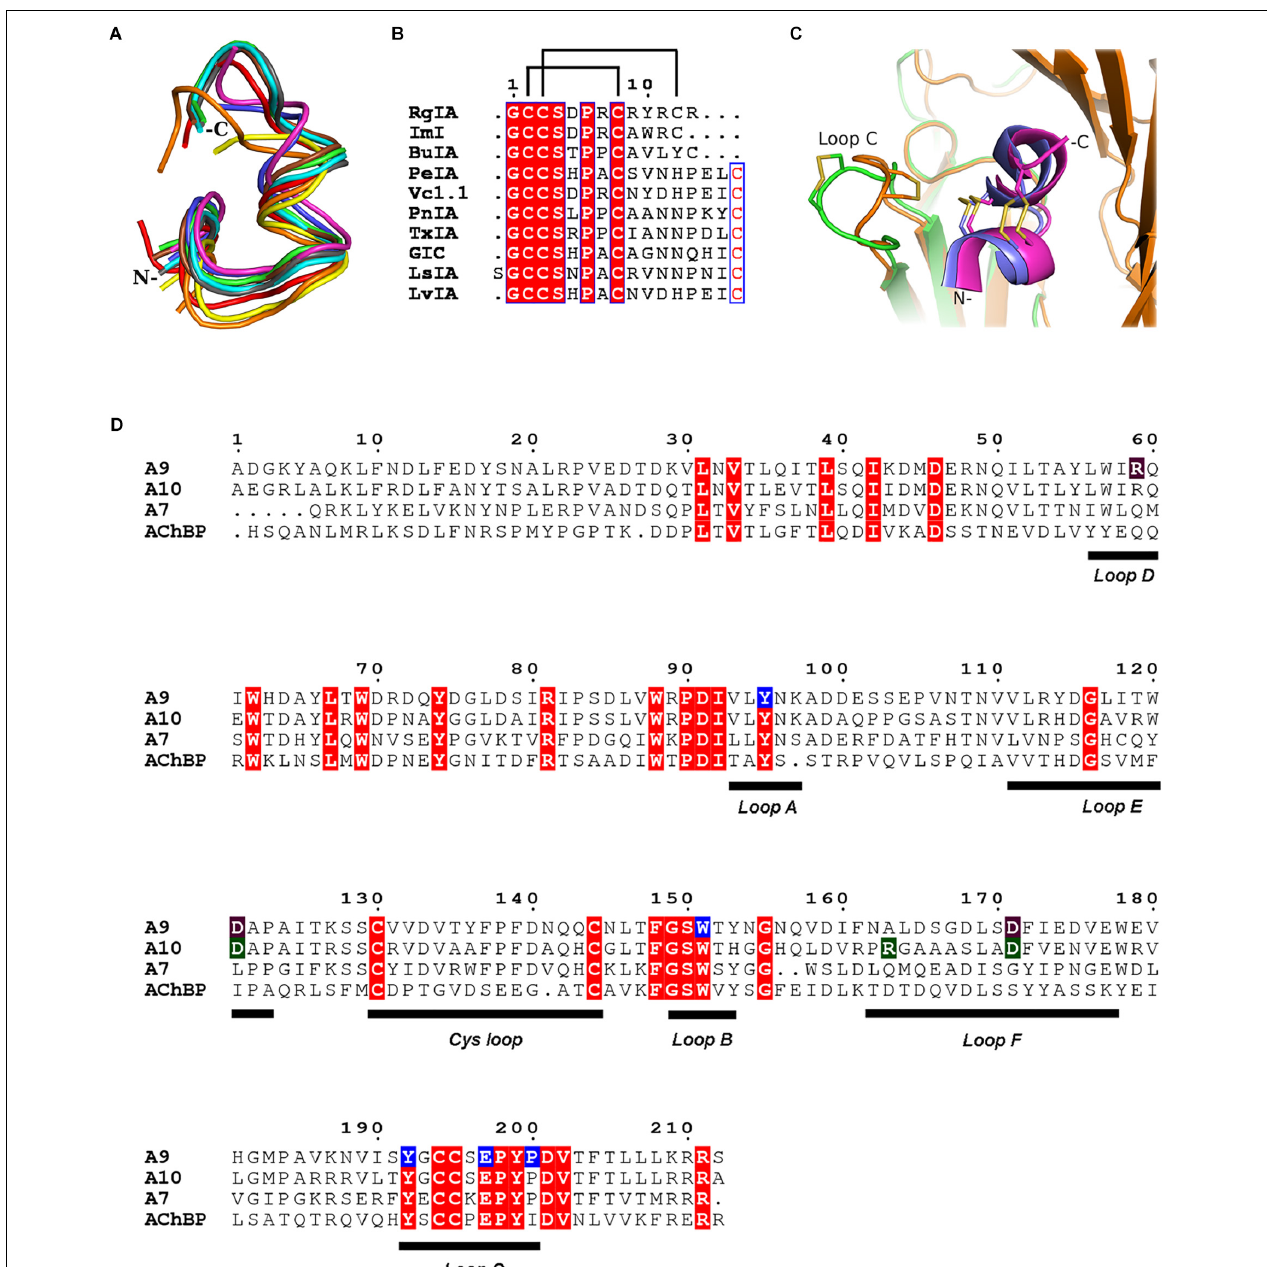
FIGURE 2 | α -Ctxs bound to α 9-ECD and homologous proteins. (A) Overlay of all crystallized α -Ctxs bound to AChBPs and of RgIA bound to α 9-ECD, as a result of the superposition of the protomers of AChBPs to the monomeric α 9-ECD (RgIA in magenta, ImI in blue, PeIA in cyan, GIC in green, PnIA in gray, LsIA in red, LvIA in brown, BuIA in yellow, and TxIA in orange). (B) Sequence alignment of crystallized α -Ctxs with AChBPs or α 9-ECD. Disulfide bridges in RgIA are indicated by lines on top of the alignment. (C) Comparison between the AChBP/ImI and α 9-ECD/RgIA complexes. AChBP in orange, α 9-ECD in green, ImI in blue, and RgIA in magenta. (D) Sequence alignment of human α 9, α 10, α 7 nAChR-ECDs and Lymnaea stagnalis AChBP. α 9(+) side-interacting residues with RgIA, as shown in the crystal structure, in blue boxes; α 9(–) and α 10(–) interacting residues with RgIA, as shown in the MD studies, in purple and green, respectively.